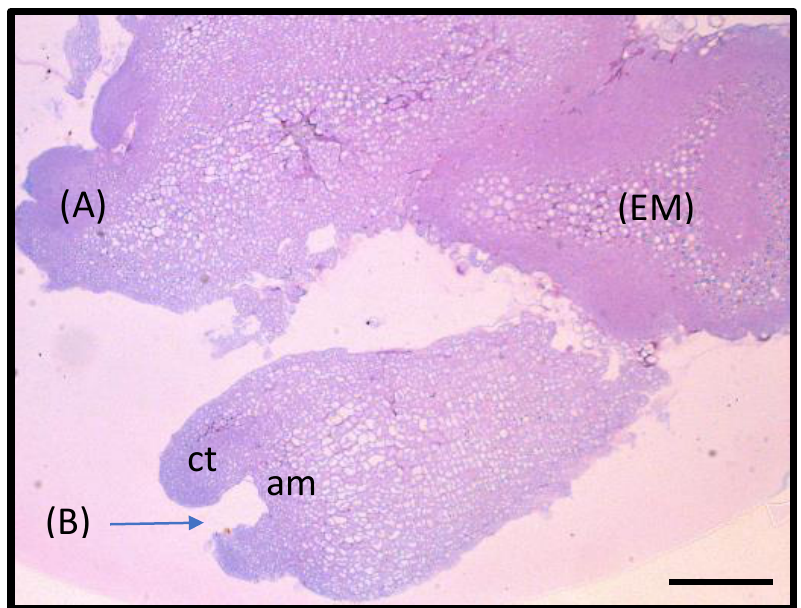
Figure 2. Histological longitudinal section of WUS embryogenic calli (EM) after 3 weeks of culture on SH1 medium showing the produced embryos at various stages of development: ( A ) globular stage somatic embryo; ( B ) cotyledonary-stage somatic embryo with two distinct cotyledons (ct) and apical meristem (am). The bar scale represents 200 μm